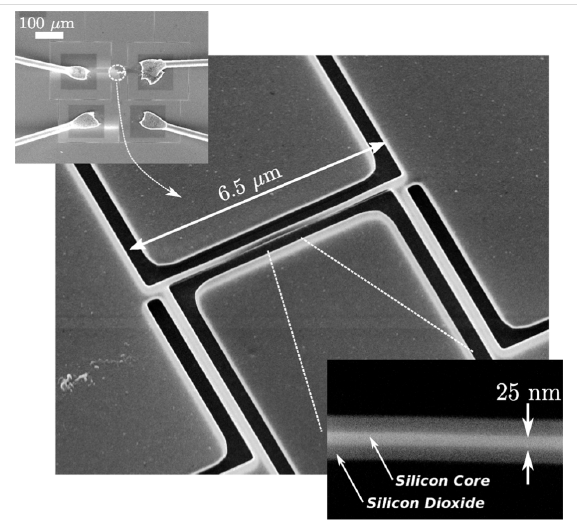
Figure 8: A composition of SEM images of a device, based on a single silicon nanowire positioned between four contacts to be used for elec- trical characterization. The top-down process allows the simultaneous fabrication of the nanowire and of the interconnections-contacts. Top left: overview of the device, middle: nanowire with two contacts at the extremities and two side contacts, bottom right: enlargement of the central region. For more details refer to the